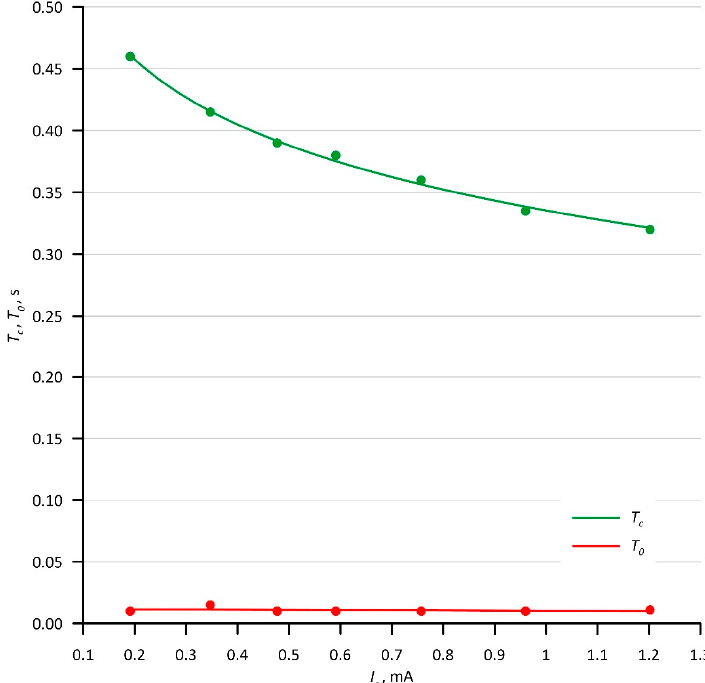
Figure 6. Dependence of the time constant T c and the delay time T 0 as a function of the intensity I e of the emission current, for thoriated tungsten cathode with dimensions d = 0.00012 m and l = 0.045 m, sensing resistors R 1 = R 2 = 0.383 Ω and V a = 100 V. The Type B relative standard uncertainty value of time is less than 0.15%.